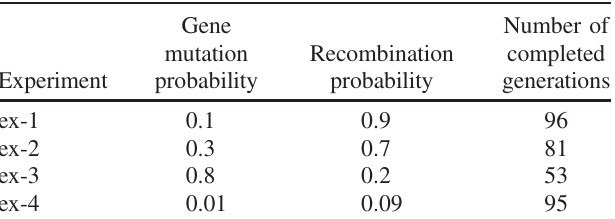
TABLE III. Input parameters for initial twenty-four hour AWA optimization experiments. The gene mutation probability was equal to the mutation probability (not shown) in all four experiments. The maximum number of individuals per generation was 80.